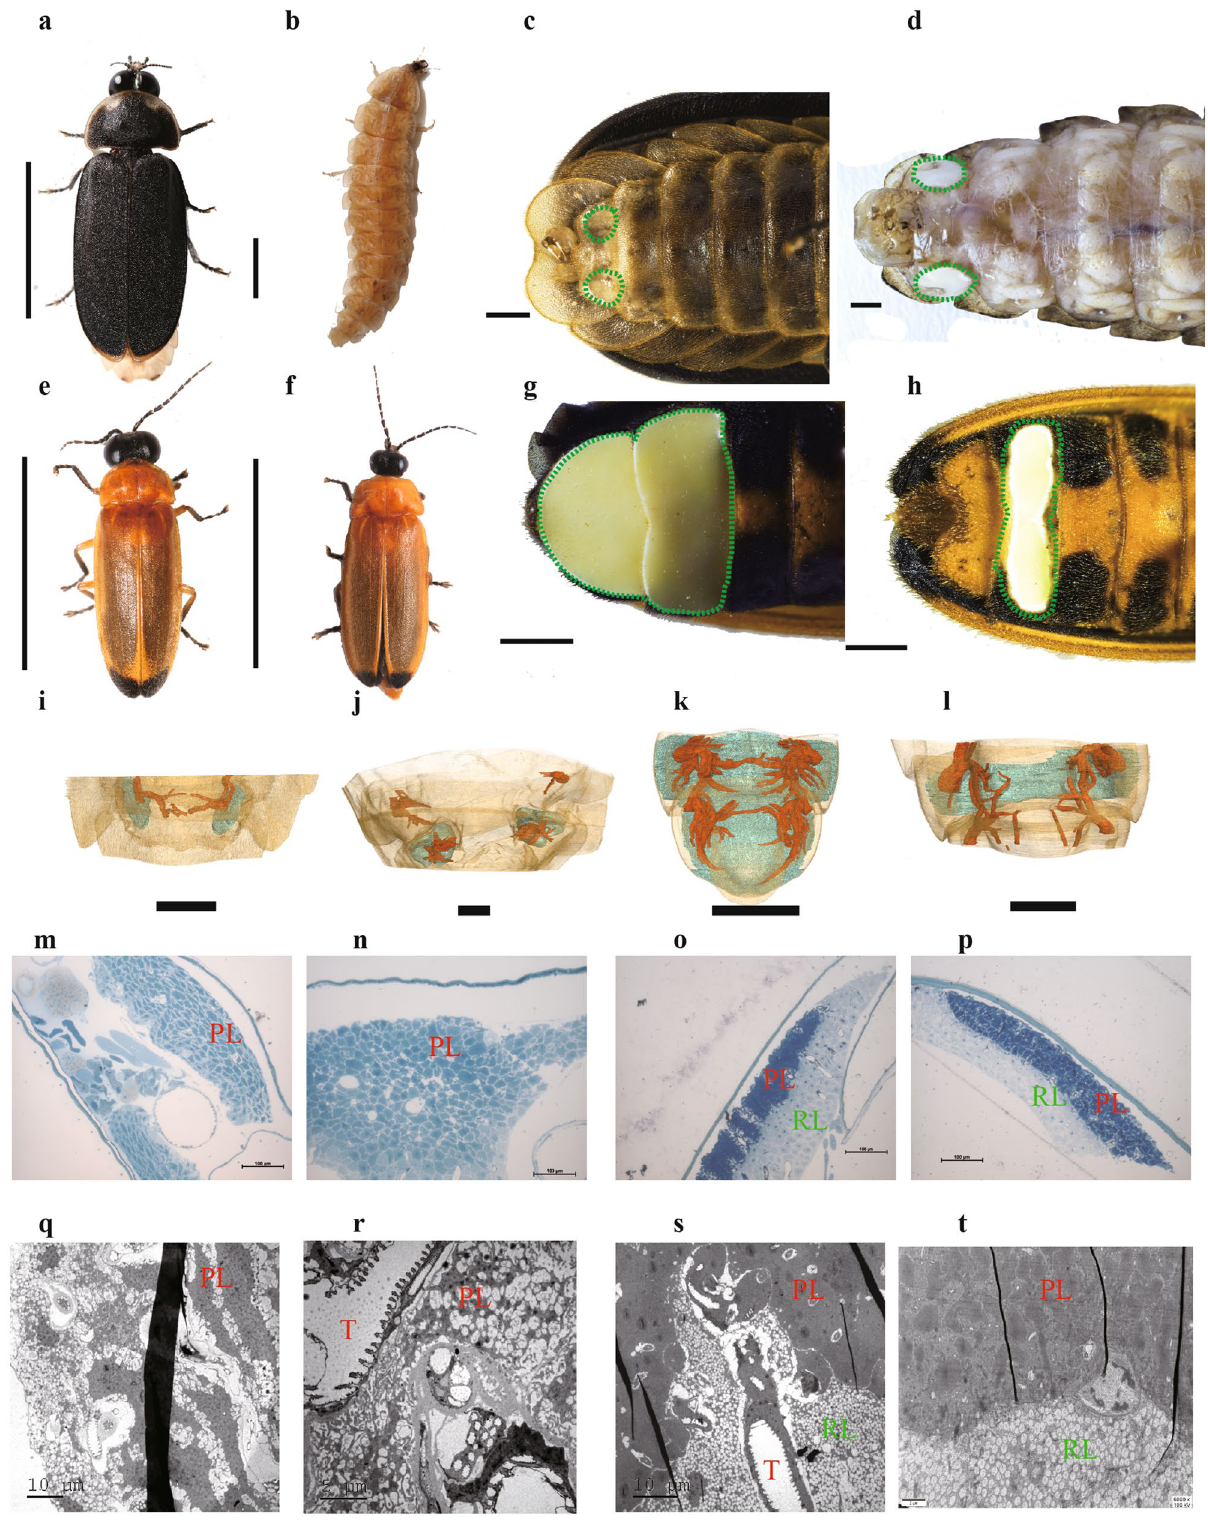
Figure 1. Adults of Lamprigera yunnana and Abscodita terminalis and their luminous organs. ( a – d ) Adults (a, male; b, female) and their luminous organs (dotted green regions) ( c , male; d , female) of L. yunnana . ( e – h ) Adults ( e , male; f , female) and their luminous organs (dotted green regions) ( g , male; h , female) of A. terminalis . Scale bars ( a – h ): 1 mm. ( i – l ) Three-dimension reconstruction of luminous organs (blue) and tracheal system (red) of male and female L. yunnana ( i , male; j , female) and A. terminalis ( k , male; l , female). ( m – p ) Semi-thin section structures of luminous organs of male and female L. yunnana ( m , male; n , female) and A. terminalis ( o , male; p , female). ( q – t ) Transmission electron microscopic structures of luminous organs of male and female L. yunnana ( q , male; r , female) and A. terminalis ( s , male; t , female). PL, Photogenic layer; RL, Reflecting layer; T,